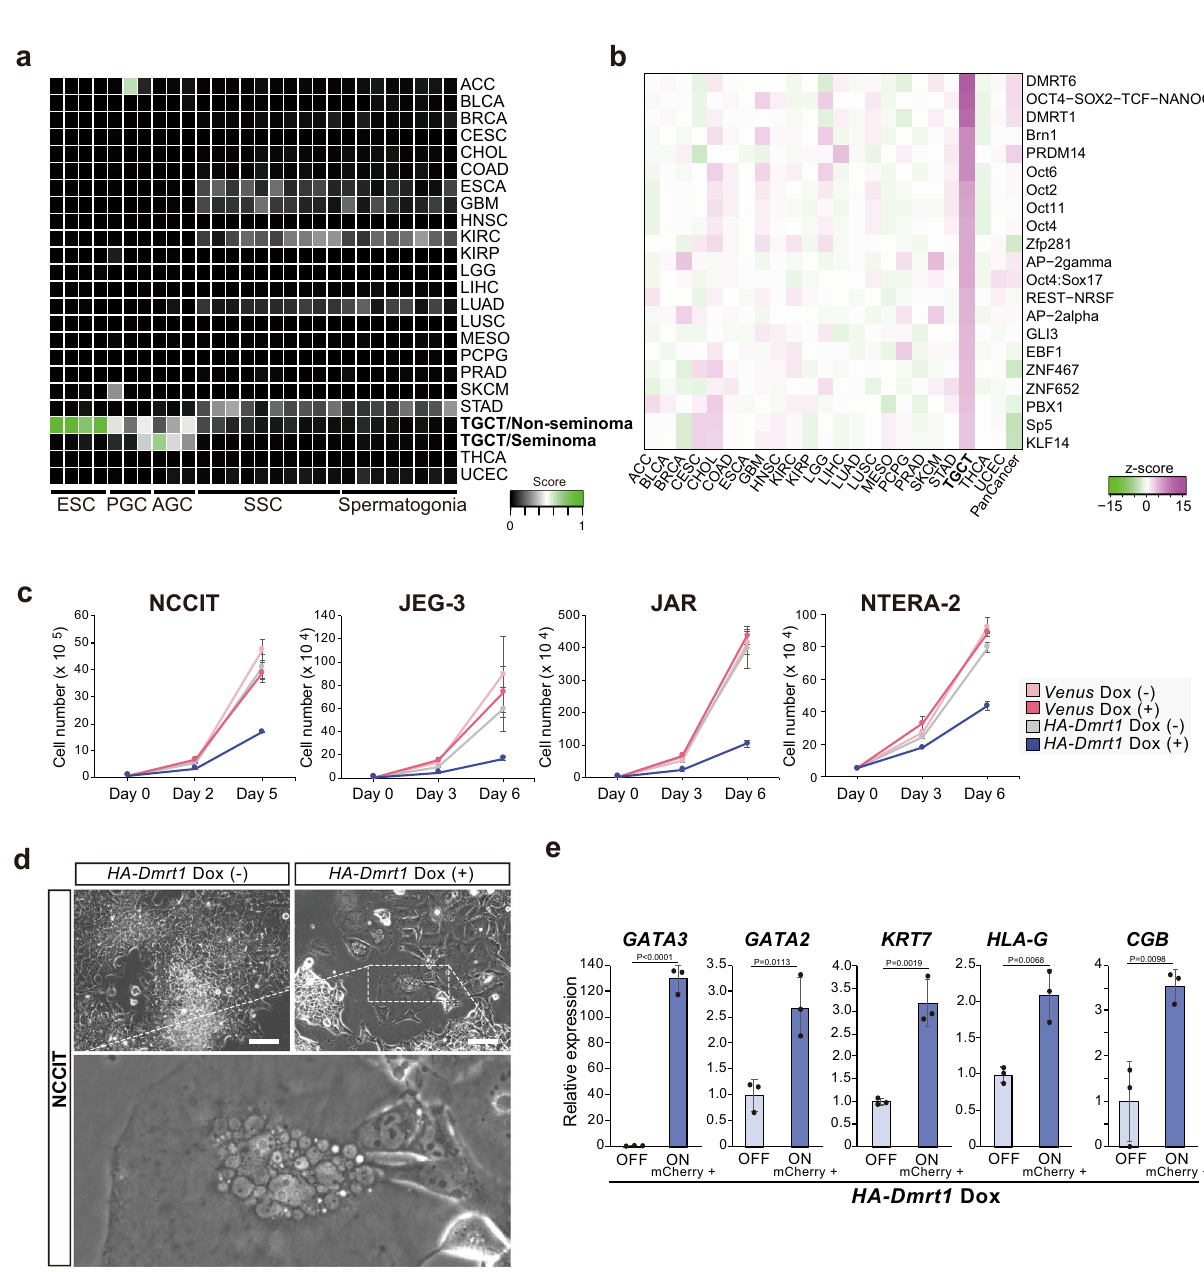
Fig. 6 DMRT1 drives in vivo reprogramming and propagation of GCT-like tumor cells. a Schematic illustration of the experimental protocol for in vivo D-OSKM reprogramming of somatic cells de fi cient for Dmrt1 . b Representative macroscopic and histological images of pancreatic tumors in Dmrt1 -KO D-OSKM chimeric mice. Immunostaining for OCT4 and Ki67 in pancreatic tumors is shown in the right panels. Scale bars: 1000 μ m (left), 200 μ m (middle and right). c – e Quanti fi cation of tumor area (c), OCT4-positive cell area in the tumor (d), and Ki67-positive cell ratio in the OCT4-positive cell area (e) in the pancreas. D-OSKM mice that developed pancreatic tumors were evaluated in this study (control, n = 10; Dmrt1 KO18, n = 2; Dmrt1 KO21, n = 5). Data are presented as means ± SD of biologically independent samples (Mann – Whitney test, two-sided). f Immunostaining for DAZL and quanti fi cation of the DAZL-positive cell area in pancreatic tumors (control, n = 10; Dmrt1 KO18, n = 2; Dmrt1 KO21, n = 5). Data are presented as means ± SD of biologically independent samples (Mann – Whitney test, two-sided) scale bars: 200 μ m. g Derivation ef fi ciency of iPSC-like colonies from pancreatic tumors (control, n = 3; Dmrt1 KO21, n = 3). Colony counting was performed at Day 7. h Immunostaining for CDX2 and quanti fi cation of the CDX2-positive cell area in pancreatic tumors (control, n = 10; Dmrt1 KO18, n = 2; Dmrt1 KO21, n = 5). Data are presented as means ± SD of biologically independent samples (Mann – Whitney test, two-sided) scale bars: 500 μ m. i qRT-PCR analyses of trophoblast-related gene expression in pancreatic tumors. Data are presented as means ± SD of biological triplicates. The mean expression level of control D-OSKM pancreatic tumors was de fi ned as 1 ( t -test, two-sided). j Schematic representation of in vivo D-OSKM reprogramming and derivation of PSCs with the expanded differentiation potential into